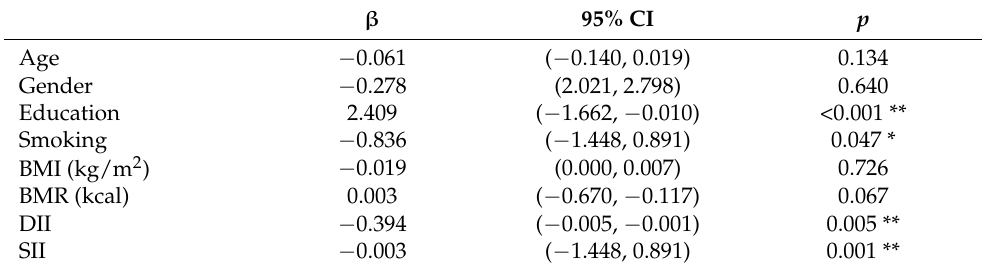
Table 4. Association between DII, SII and cognitive function.